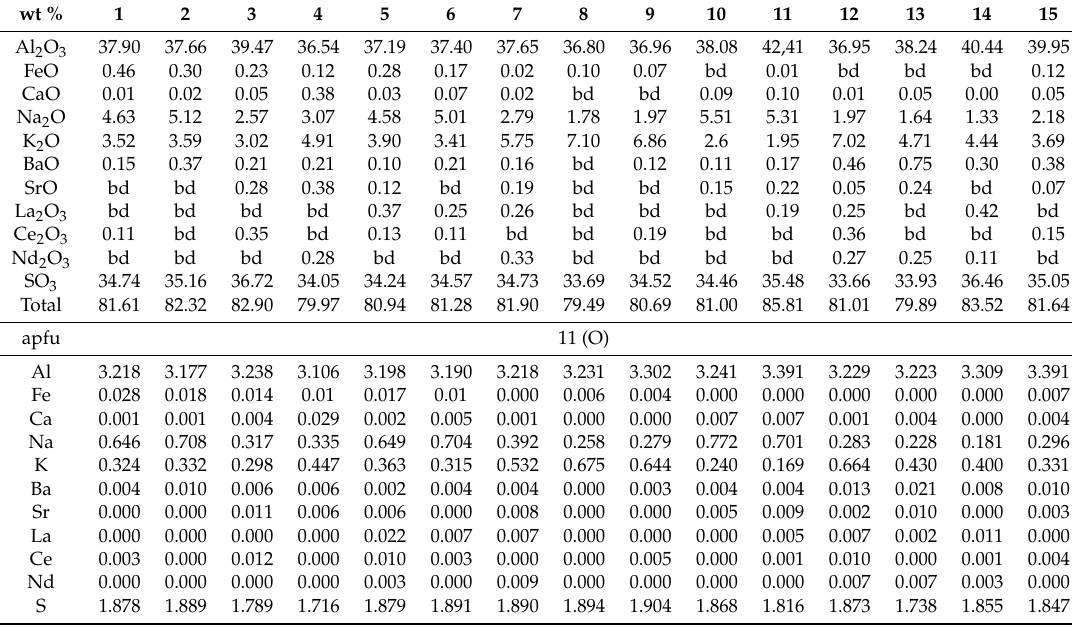
Table 3. Representative EPMA data of members of the alunite–natroalunite solid solution from the advanced argillic alteration zone at the Konos Hill prospect, NE